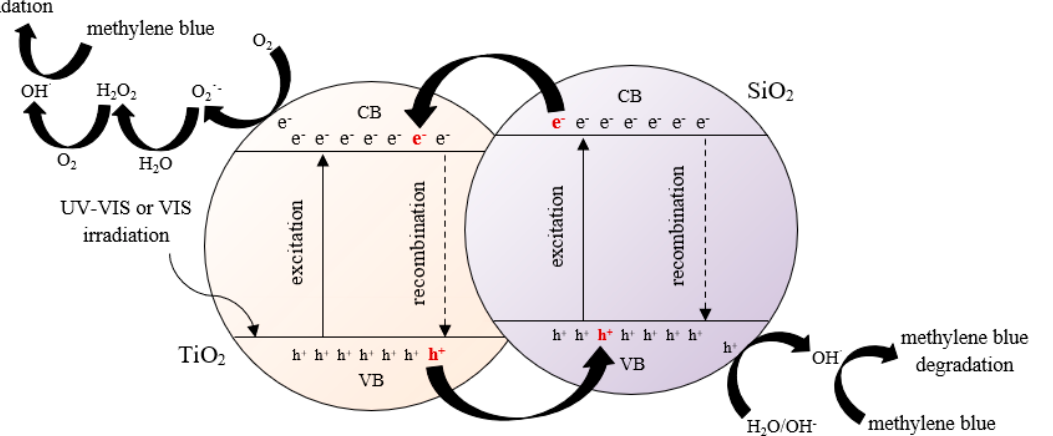
Figure 11. Degradation mechanism of methylene blue under UV-VIS and VIS (based on [52]).